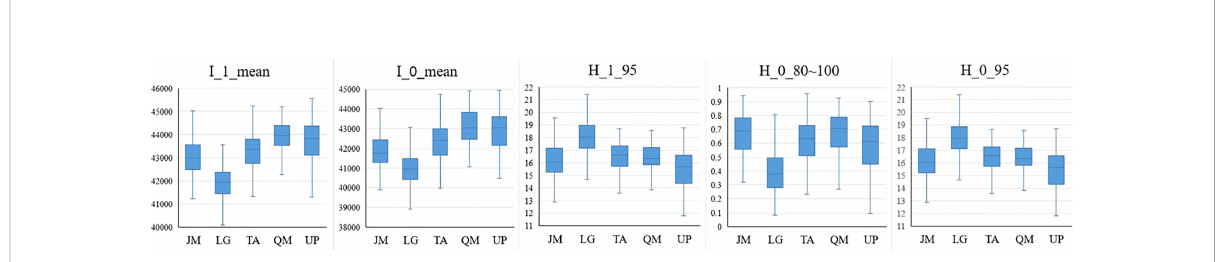
FIGURE 10 LiDAR features capability for tree species discrimination (JM Juglans mandshurica ; LG Larix gmelini ; TA Tilia amurensis ; QM Quercus mongolica ; UP Ulmus pumila